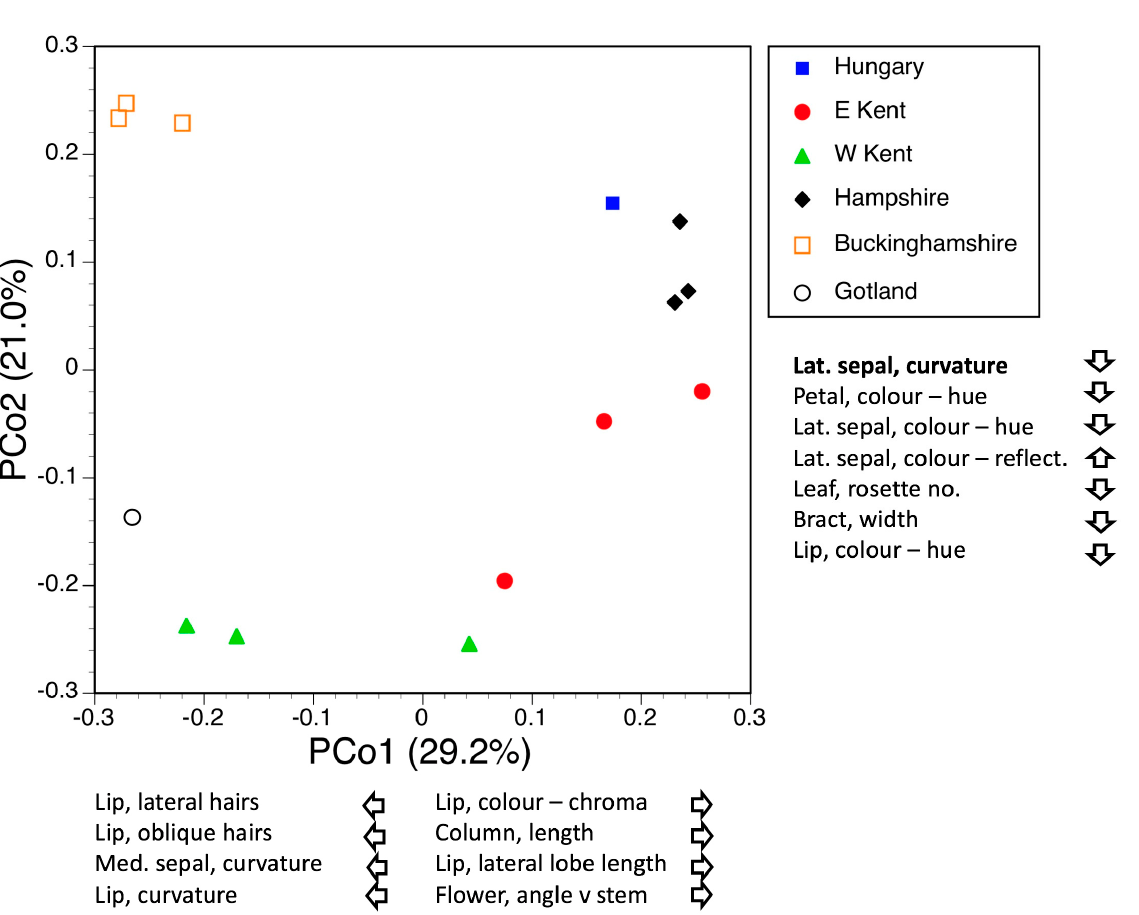
Figure 15. Plot of principal coordinates 1 and 2 for the macrospecies Insectifera, labelled according to six regions of origin: 14 individuals from six localities and 40 variable characters. Characters contributing to each coordinate are listed in descending order, with arrows indicating the direction of increase in the value of each character (boldface characters dominate that coordinate).